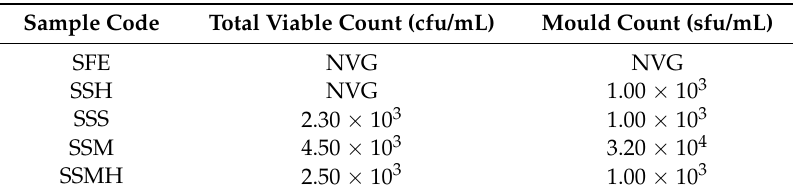
Table 4. Microbial counts of soursop drinks.